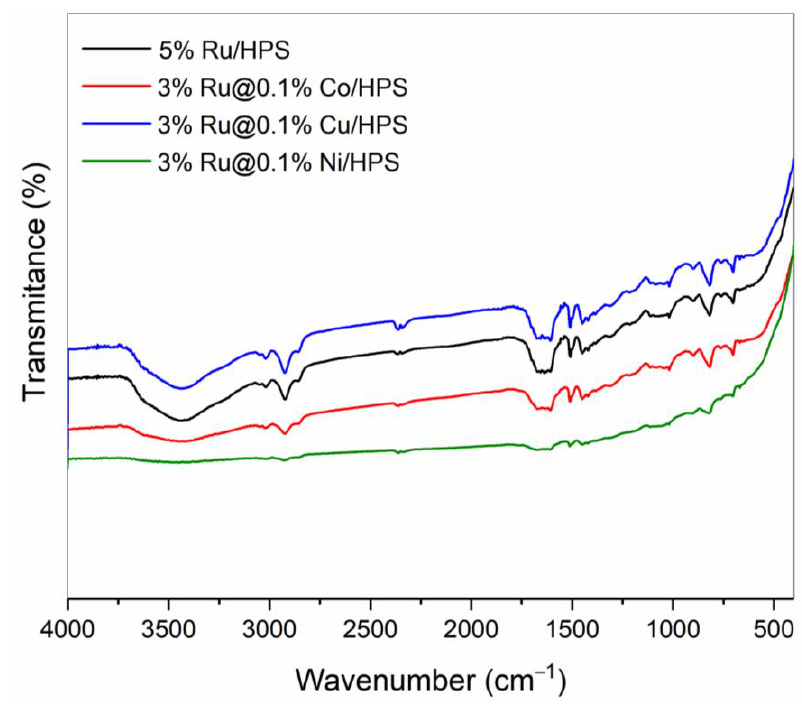
Figure 2. Ruthenium and doped ruthenium/HPS catalysts FT-IR compilation. To investigate the nature and the amount (mmol g − 1 ) of the acid sites present in these materials, they were analyzed by infrared spectroscopy using pyridine as a probe molecule.